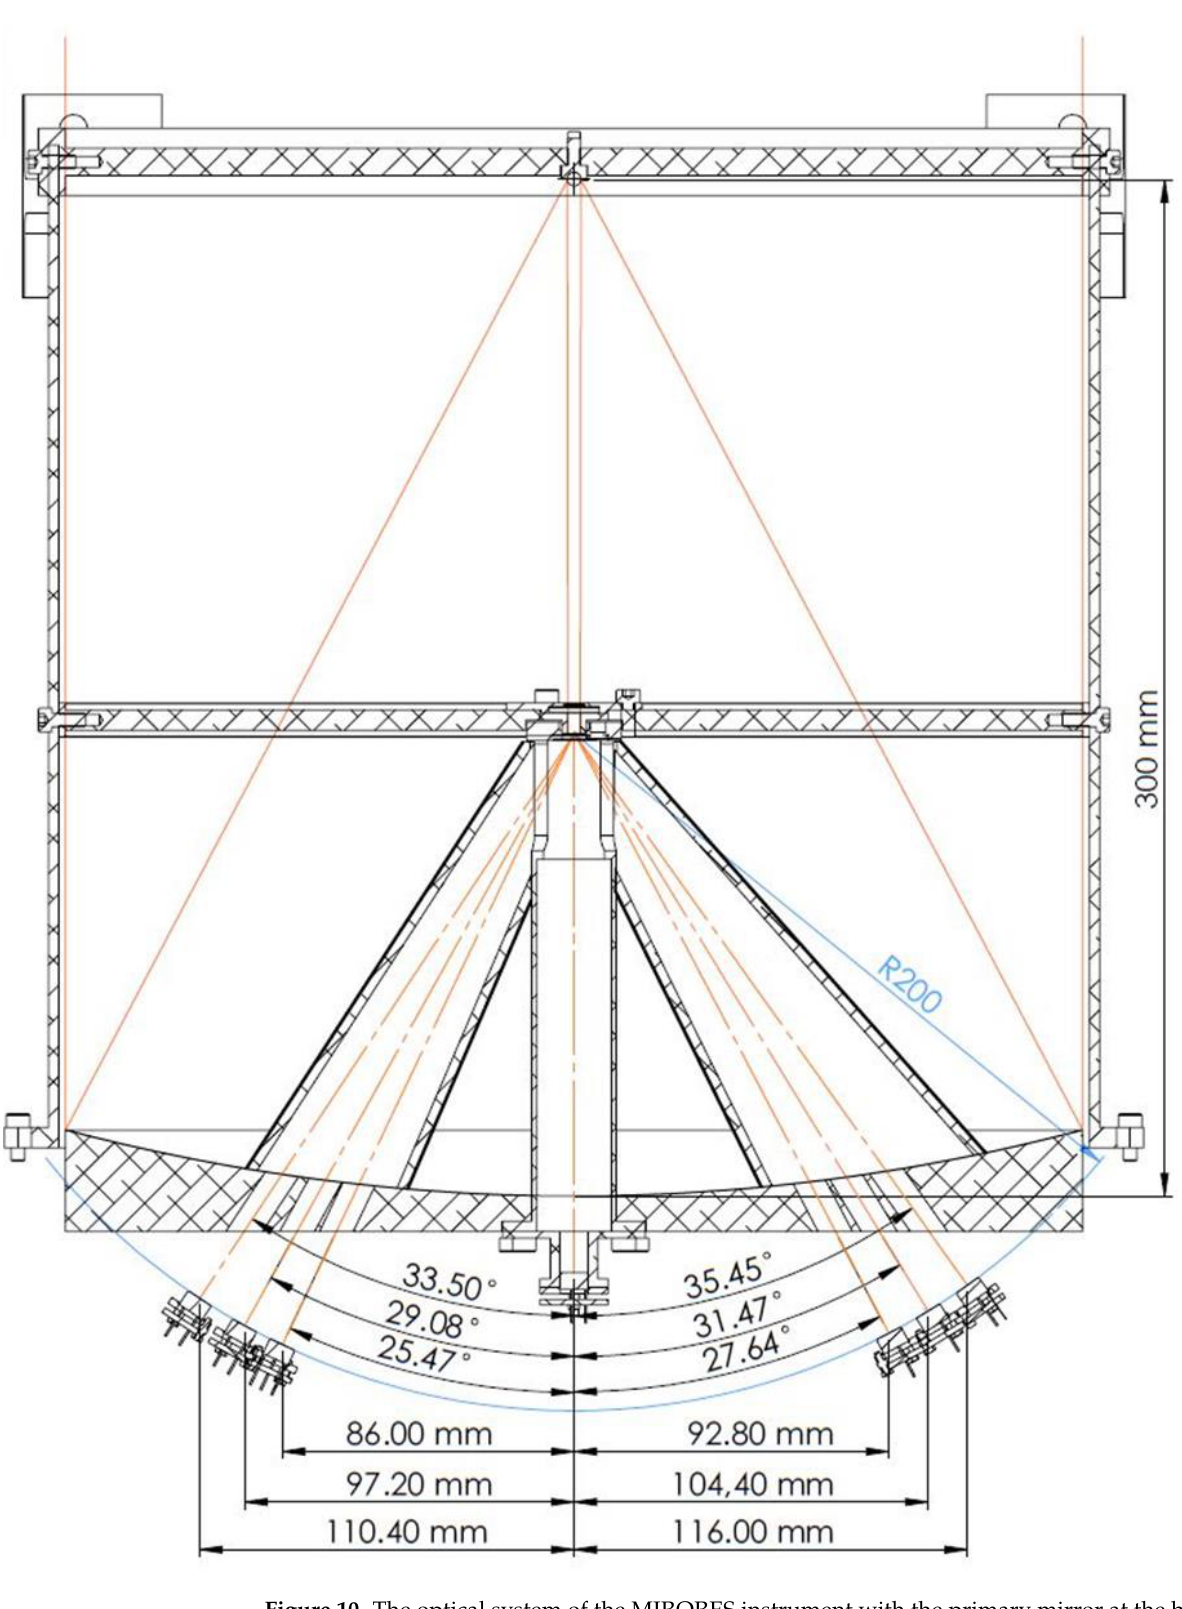
Figure 10. The optical system of the MIRORES instrument with the primary mirror at the bottom, and the secondary mirror at the top. Orange solid lines: incident radiation; orange dash–dotted lines: refracted radiation. R200 is the distance between the detectors and diffraction grating (200 mm). The thin blue curve marks this distance of 200 mm from the diffraction grating, and all the detectors are situated along this theoretical curve.